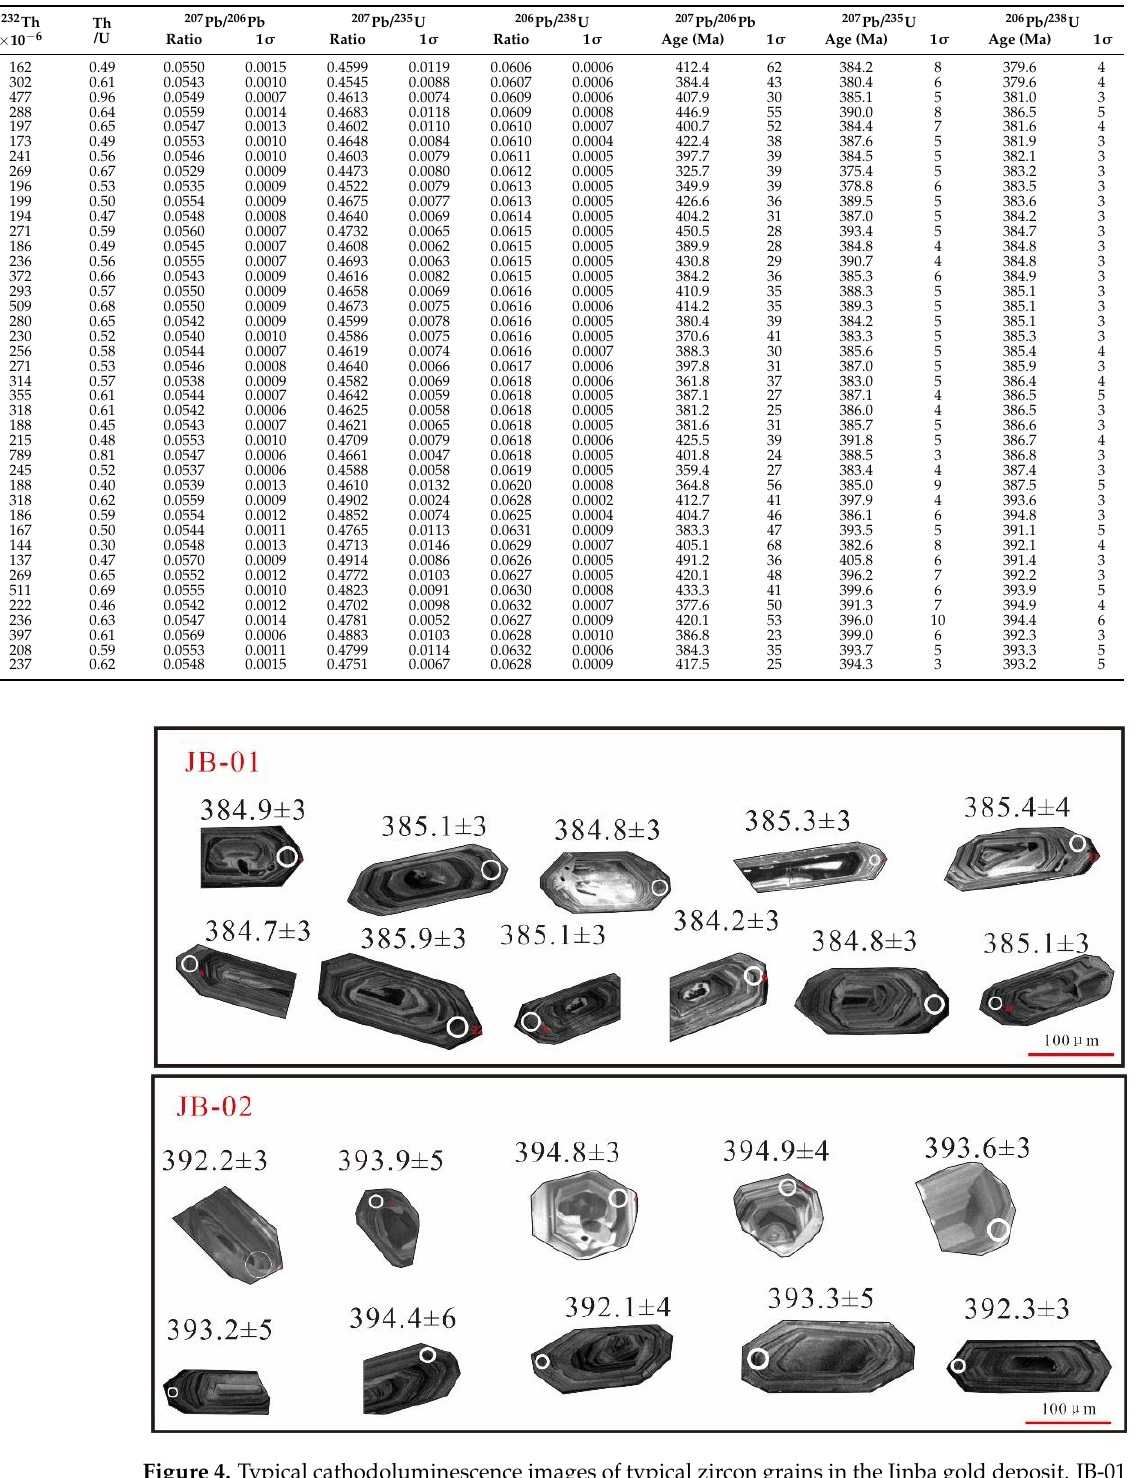
Table 1. LA-MC-ICP-MS U–Pb data of zircons from granite and diorite dykes of the Jinba gold deposit.